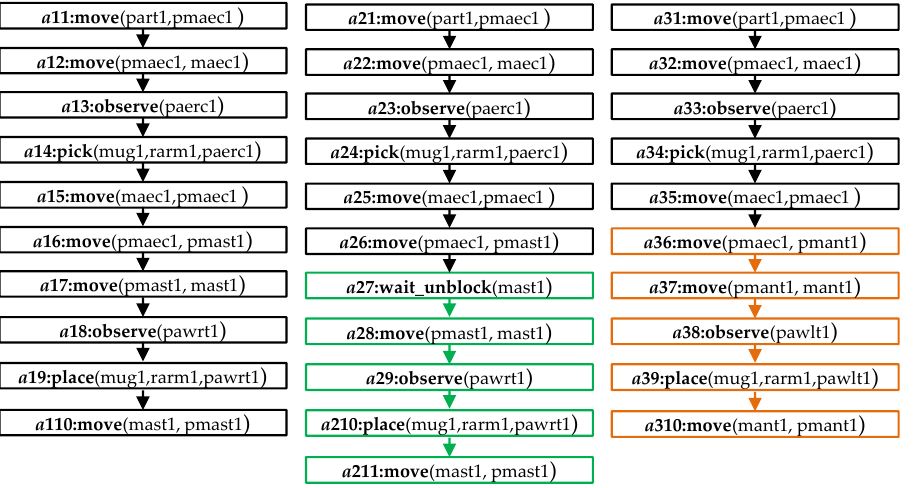
Figure 4. The activity schemas learned from the three sub-scenarios. The abstract operator sequences of ma 1 , ma 2 and ma 3 are presented from left to right. Each abstract operator is represented by a rectangular box, in which “ a x“ is its abbreviation. The green part indicates a sequence in ma 2 that differs from ma 1 . The orange part indicates a sequence in ma 3 that differs from ma 1 .